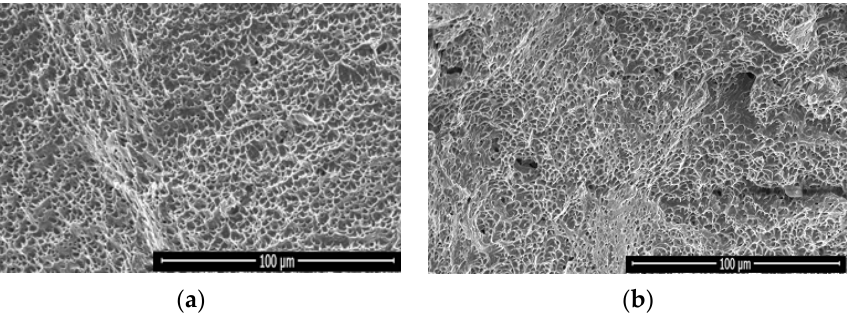
Figure 13. Fractograph of Austenitic stainless steel 316L impact Charpy “V” notch for ( a ) TIG Welded Zone (500×) and ( b ) ATIG Welded Zone (500×)